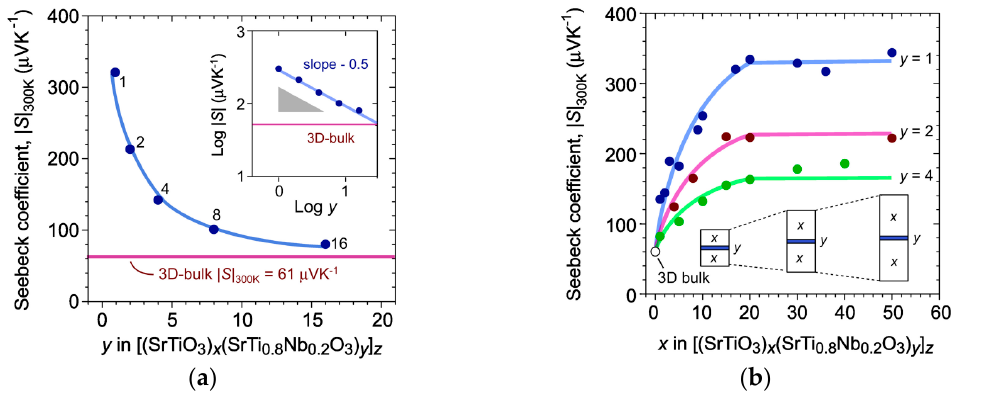
Figure 5. Thermo-emf dependence of Sr(Ti 0.8 Nb 0.2 )O 3 of layer at 300 K for [SrTiO 3 ] x /[Sr(Ti 0.8 Nb 0.2 )O 3 ] y superlattice: ( a ) On y (thickness of the conducting layer) at sufficient thickness of insulating layers; ( b ) on x (thickness of insulating layers) at sufficient thickness of conducting layers. Reproduced from [101].